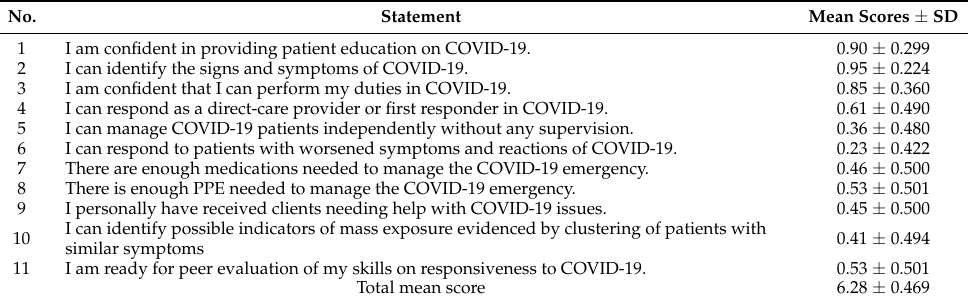
Table 3. Participants’ scores regarding their perceived response towards COVID-19 ( n = 152).